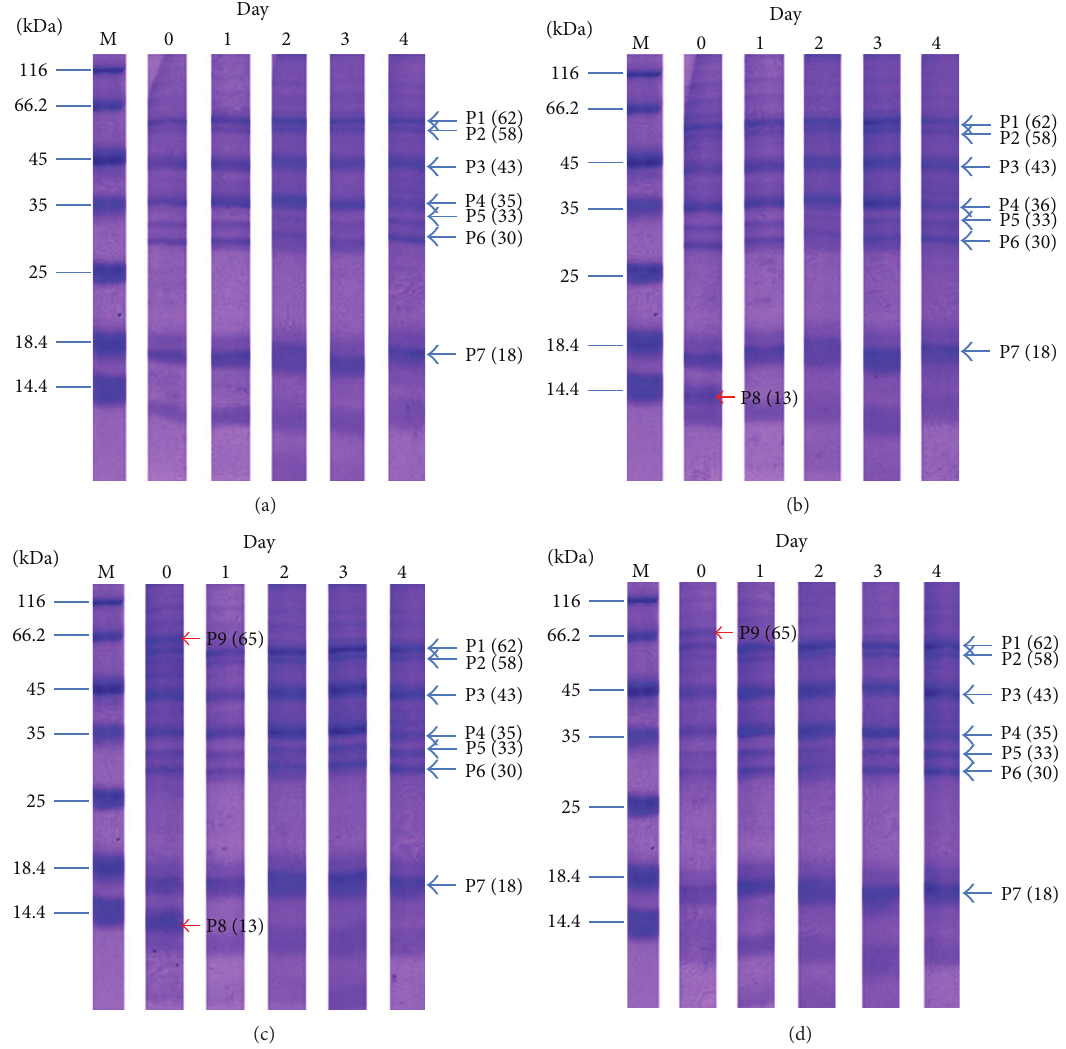
Figure 3: The proteins profiles of the salivary glands was followed up on days 0, 1, 2, 3, and 4 after mosquitoes feeding on sugar (a), normal blood (b), P. vivax -infected blood (c), P. falciparum -infected blood (d). Their molecular weights were presented on SDS polyacrylamide gels with CBB